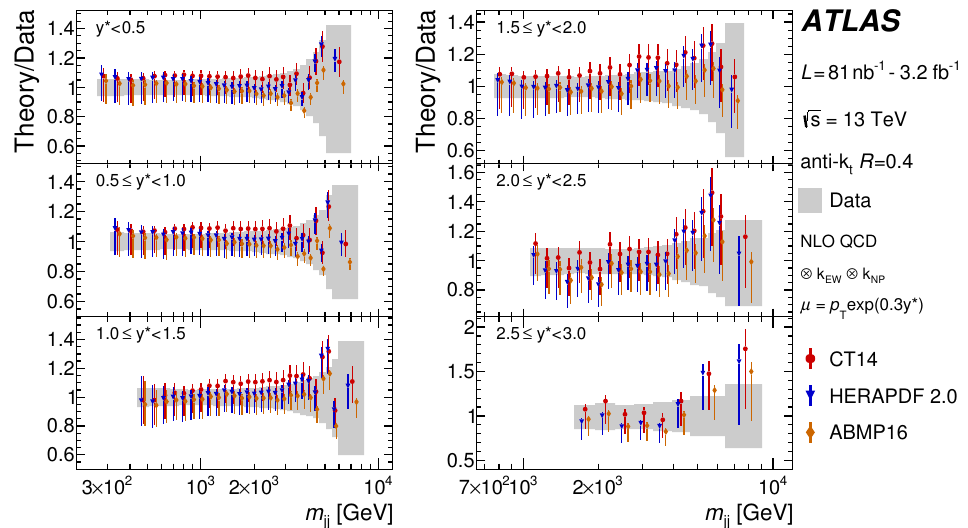
Figure 10 . Comparison of the measured dijet cross-sections and the NLO pQCD predictions shown as the ratios of predictions to the measured cross-sections. The ratios are shown as a function of the jet m jj in six y (cid:3) bins for anti- k t jets with R = 0 : 4. The predictions are calculated using NLOJET++ with three di(cid:11)erent PDF sets (CT14, HERAPDF 2.0, ABMP16) and non- perturbative and electroweak corrections are applied. The uncertainties of the predictions, shown by the coloured lines, include all the uncertainties discussed in section 9. The grey bands show the total data uncertainty including both the systematic (JES, JER, unfolding, jet cleaning, luminosity) and statistical uncertainties.